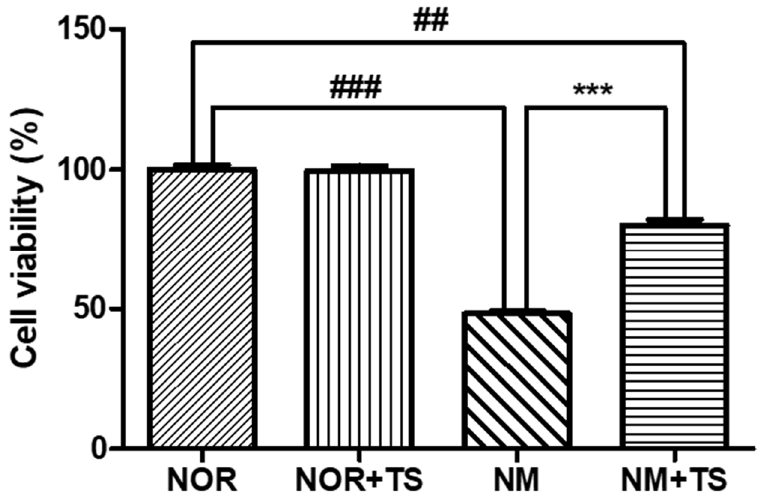
Figure 1. Comparison of cell viability in neomycin-treated HEI-OC1 cells with and without TS treatment. Data are presented as means ± SEM of three independent experiments conducted in triplicates. ## p < 0.01 (NOR vs. NM + TS). ### p < 0.001 (NOR vs. NM). *** p < 0.001 (NM vs. NM + TS).